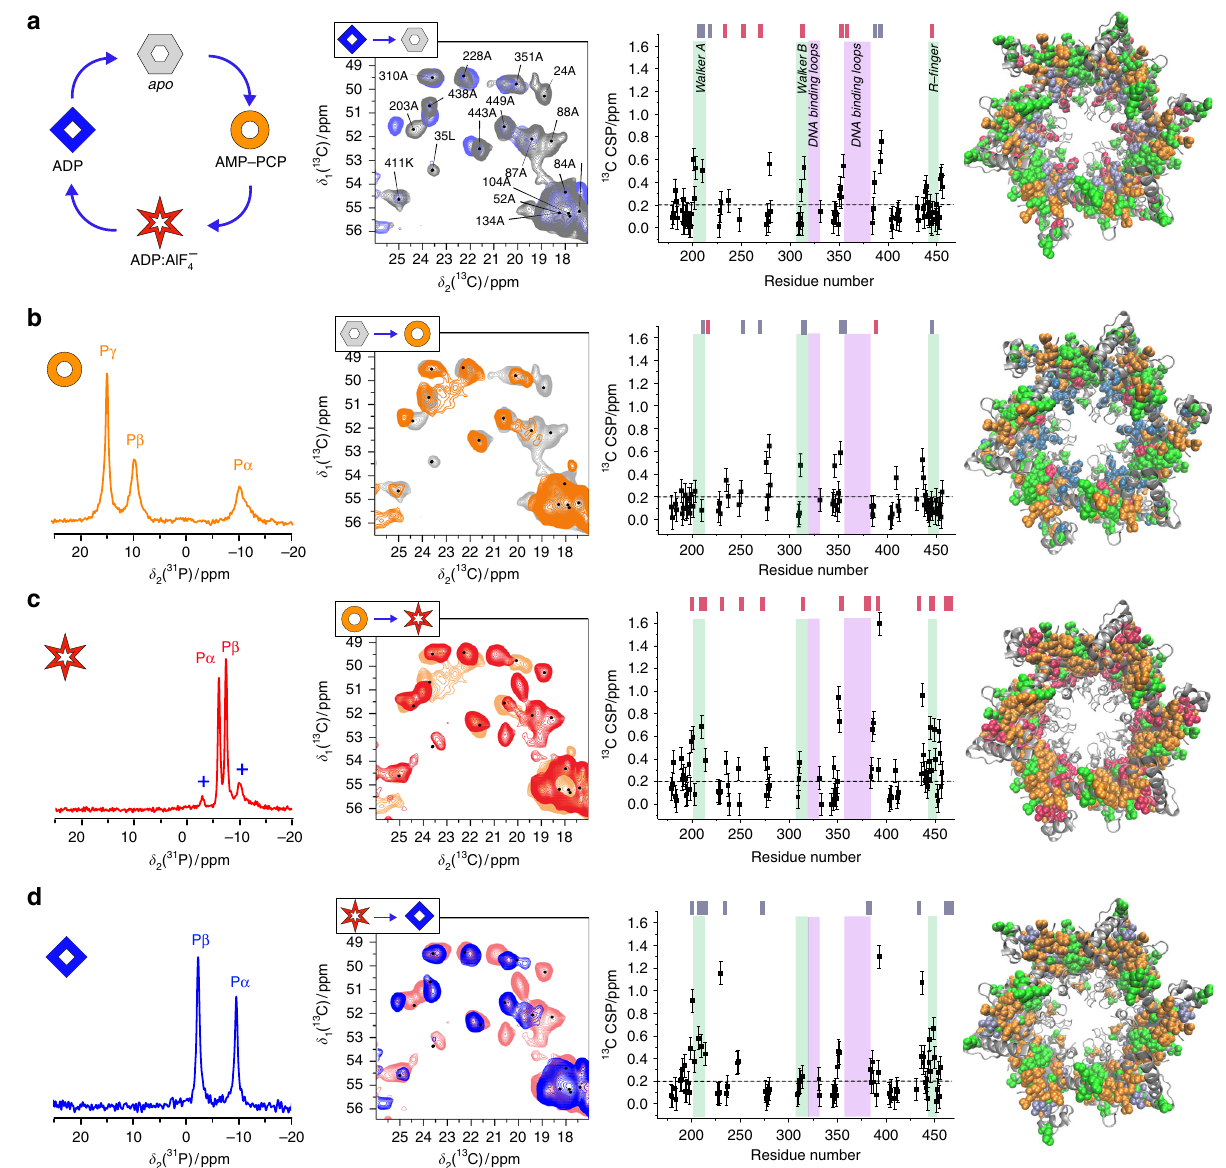
Fig. 2 ATP hydrolysis equivalence scheme in the motor domain in the absence of DNA. Conformational changes in DnaB during the ATP hydrolysis cycle as shown in a , leftmost panel (see also Fig. 1b). Left column: 31 P spectra of the three ATP analogues of a . + Denotes a minor contribution of the ADP complex shown in d . Second column: spectral fi ngerprints from the alanine C α /C β region of 13 C- 13 C 20 ms DARR correlation spectra, compared to the ones of the previous step in the cycle (grey: apo, orange: AMP-PCP, red: ADP:AlF 4 − , blue: ADP). The spectrum of apo DnaB is taken from reference 24 . Third column: ffiffiffiffiffiffiffiffiffiffiffiffiffiffiffiffiffiffiffiffiffiffiffiffiffiffiffiffiffiffiffiffiffiffiffiffiffiffiffiffiffiffiffiffiffiffiffiffiffiffiffiffiffiffi (cid:3) (cid:4)r Δ δ 13 C α ð Þ 2 þ Δ δ 13 C β ð Þ 2 13 C C α -C β CSPs (calculated according to CSP ¼ 1 ) comparing again with the spectrum from the previous step. The dashed line 2 represents a threshold above which we classify the CSPs as indicative for structural changes. The error bars (identical for all residues) are estimated to 0.1 ppm from the differences in the experimental spectra. The last column shows the 13 C CSPs plotted on a model based on the X-ray structure of Hp DnaB complexed with ADP:Mg 2 + (residues 174 – 488 are shown, pdb 4ZC0, no electron density was observed for ADP:Mg 2 + 7 ) (green: CSP < 0.2 ppm, orange: CSP ≥ 0.2 ppm, grey: unassigned). Newly appearing or disappearing signals are marked by pink or steel blue spheres, respectively, on the structure and their residue numbers are indicated by pink or steel blue bars on top of the CSP plots in the third column (for detailed residue numbers see Supplementary Tables 2 and 3). Known structural motifs are highlighted in the third column in green (Walker motifs and R- fi nger) and purple (DNA-binding motifs). All source data for the chemical-shift values of columns 1 and 3 are listed in the Source Data fi